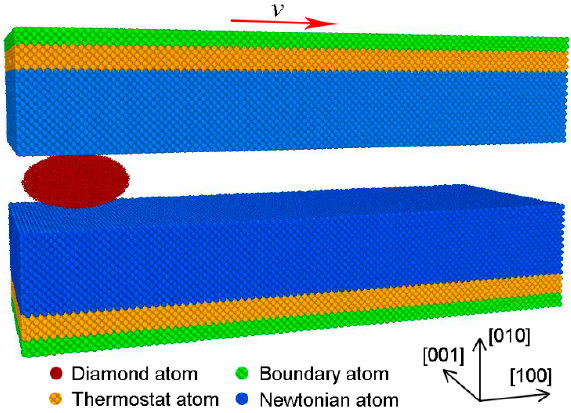
Figure 1. The scheme of initial atomic model of three-body abrasion.